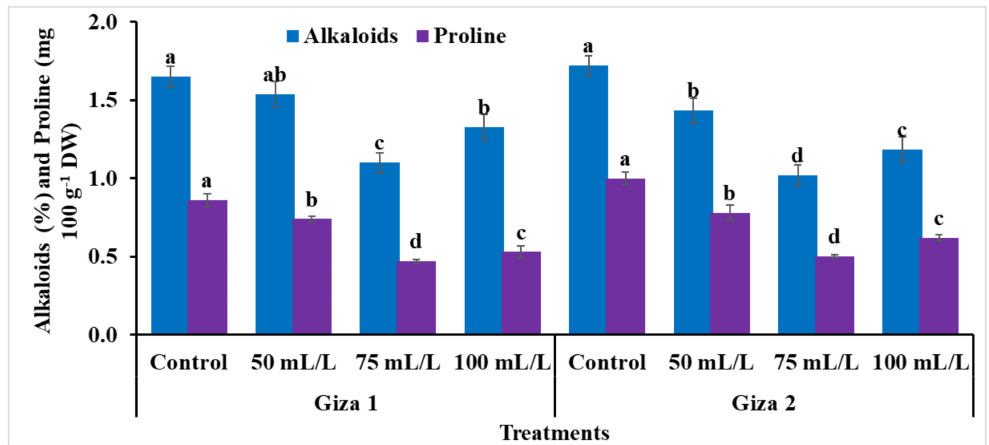
Figure 5. Effect of four AYE exogenous applications on alkaloids and proline of two lupine cultivars grown in reclaimed- saline soil. For each parameter, treatments followed by the same letter are not significantly differed at p ≤ 0.05. Error bars are ± Standard Error (SE).